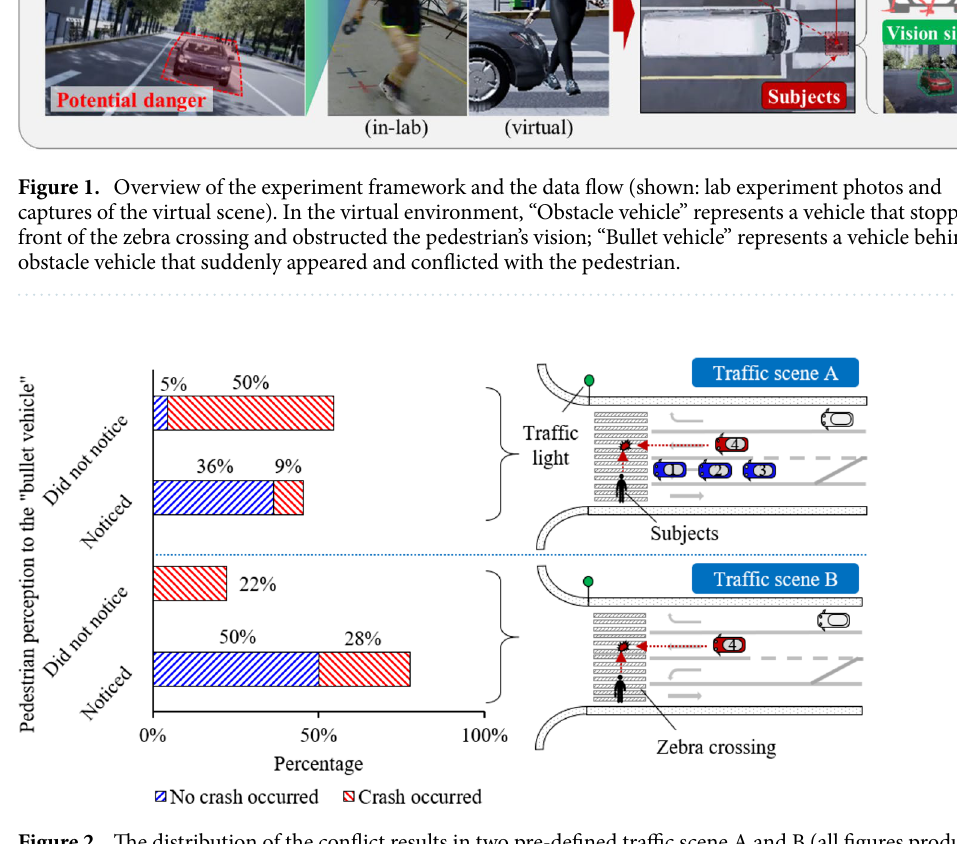
Figure 2. The distribution of the conflict results in two pre-defined traffic scene A and B (all figures produced by authors). Traffic scene A: road crossing with a hidden “bullet vehicle” (vehicle ④ ) upcoming behind visual obstacles (stopping vehicle ① , ② , ③ ); Traffic scene B: road crossing with the “bullet vehicle” (vehicle ④ ) upcoming without visual obstacles. “No crash occurred” denotes the cases with successful avoidance of the vehicle–pedestrian collision, “crash occurred” denotes the cases in which the collision between the virtual “bullet vehicle” and the pedestrians would not be not